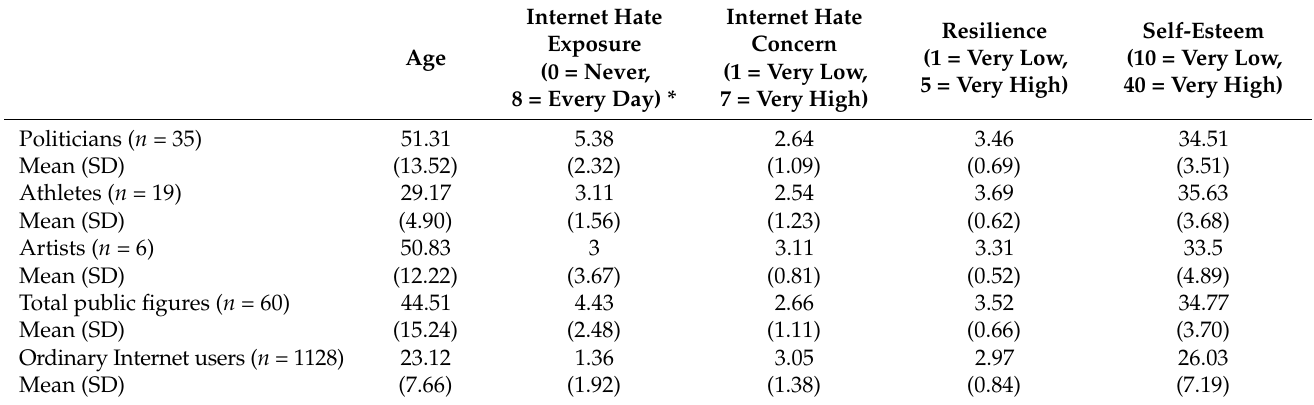
Table 1. Descriptive statistics of both